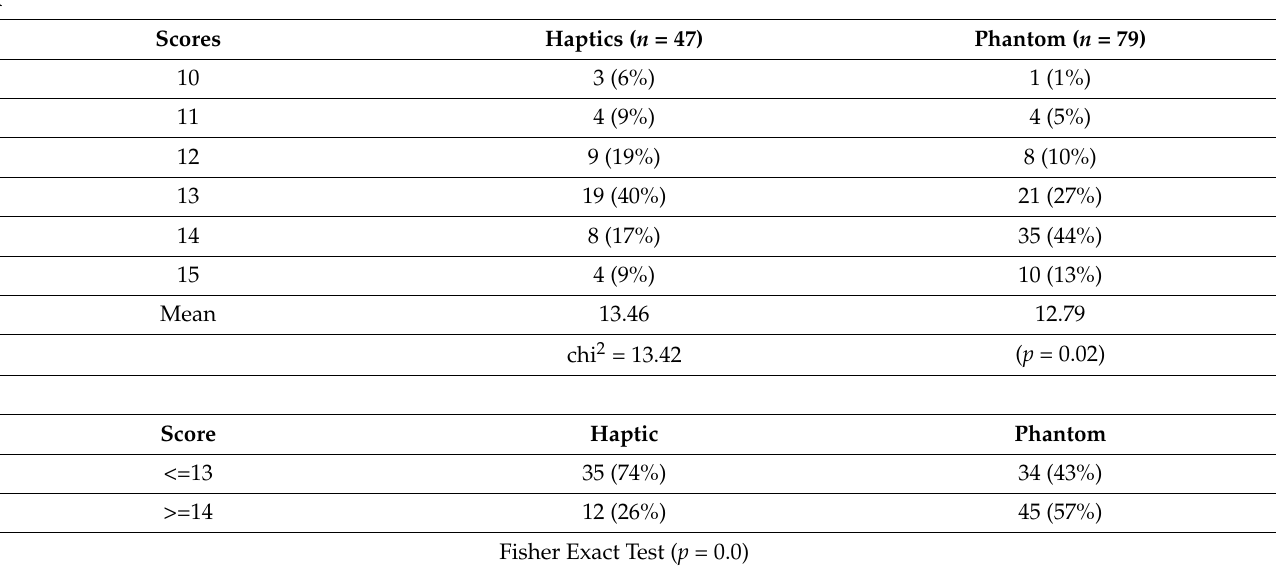
Table 4. A: Comparison on overall performance of cavity preparation (scale range 5 to 15) ( n =